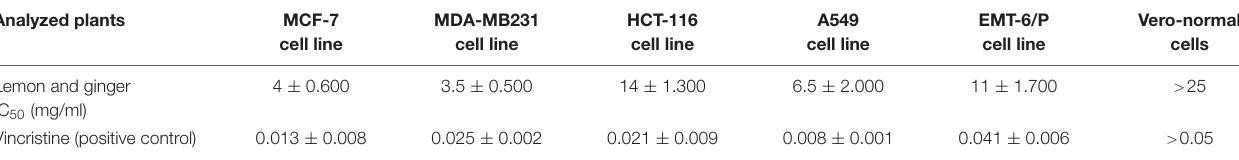
and ginger combination showed potent antiproliferative activity against the MCF-7, MDA-MB231, HCT-116, A549, EMT-6/P, and Vero (normal cells) cell lines ( Table 1 ).